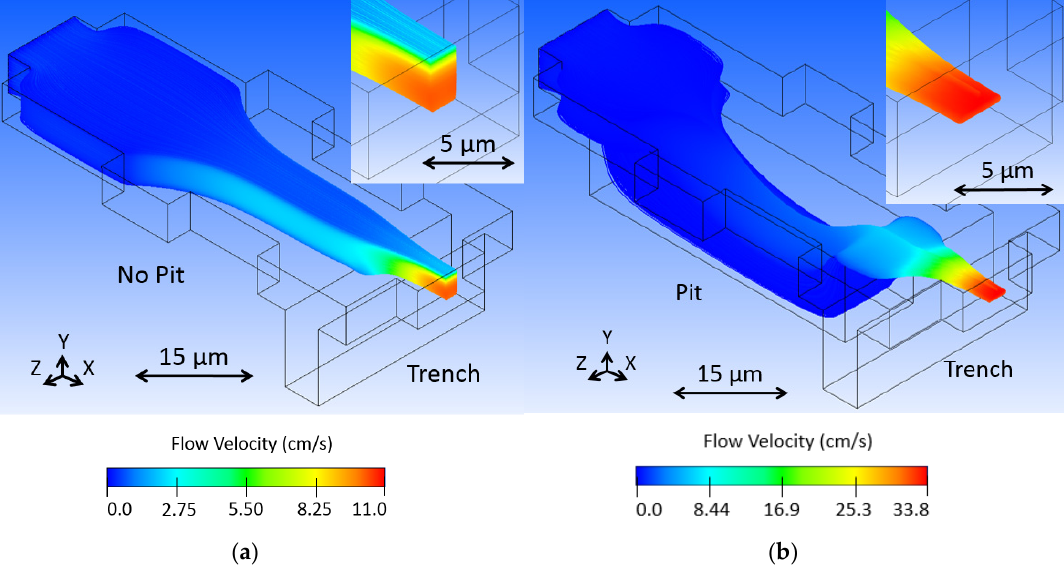
Figure 5. Variations were modeled to show how fluid channel shape and function alter the hydrodynamic focusing effect. ( a ) No pit leaves the horizontally focused sample stream near the top of the channel, a sort of 2.5D HDF. ( b ) Increasing buffer flow by 2.5 times better shapes the sample stream and removes the bridge of the nose shape.